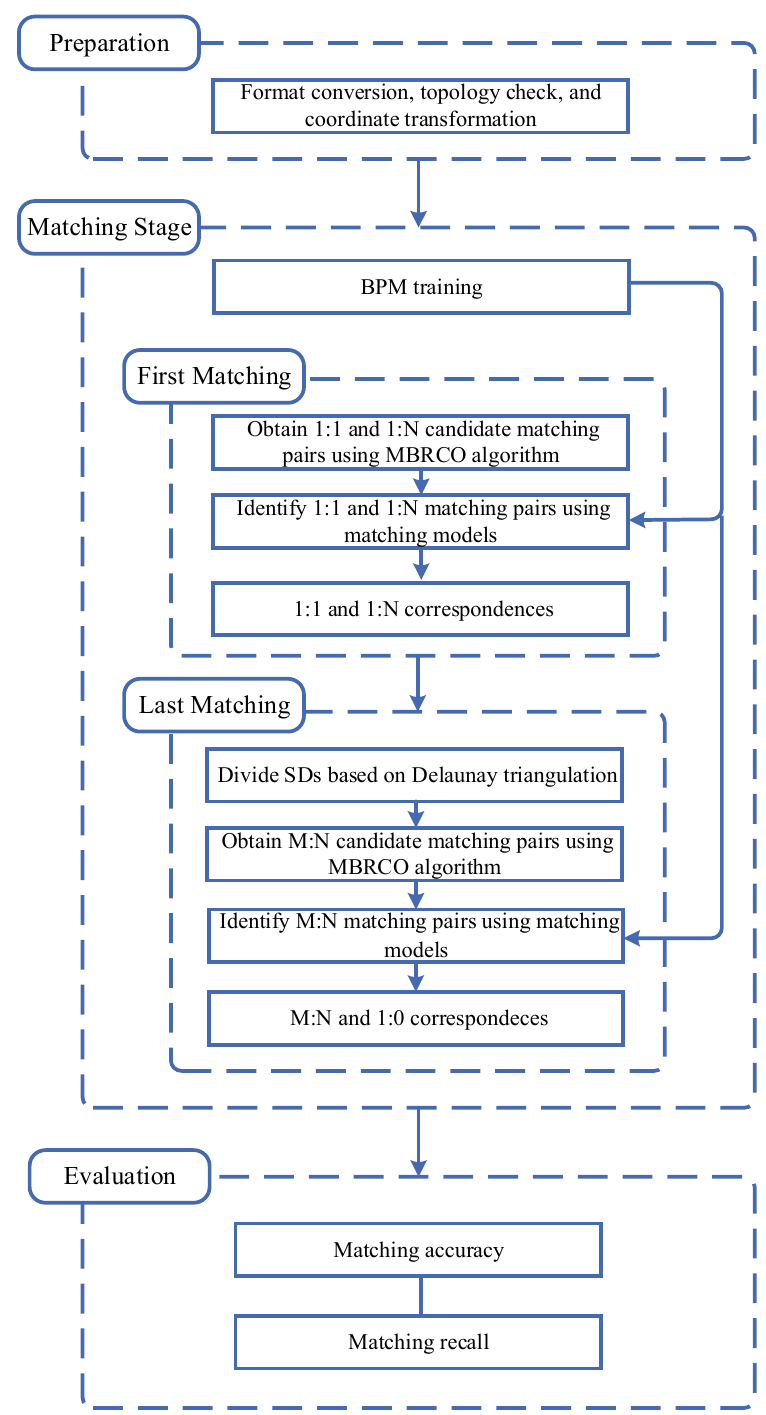
Figure 4. Multiscale Spatial Polygonal Object Matching workflow.